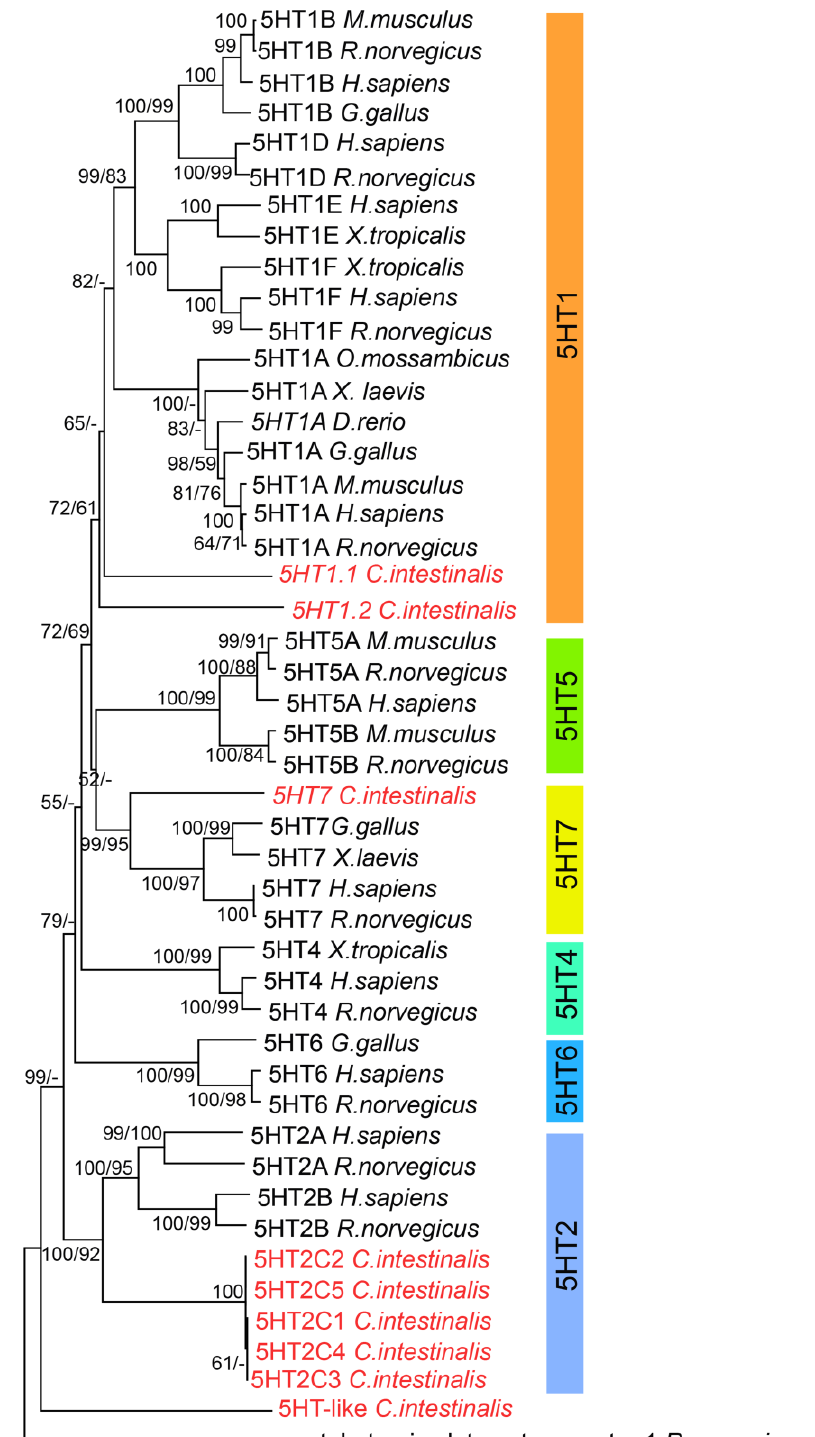
Figure 1. Phylogenetic tree of metabotropic serotonin receptors in vertebrates and Ciona . The evolutionary history was inferred using both the maximum likelihood (ML) and neighbor-joining (NJ) methods. The NJ tree is shown with bootstrap values for both NJ and ML analyses (first and second values, respectively). The percentage of replicate trees in which the associated taxa clustered together in the bootstrap test (500 replicates) is shown next to the branches. Bootstrap identical values in both NJ and MK are shown only once and values under 50% were collapsed. Differences in the two analyses are reported in the ML with an absent value. The tree was rooted using rat metabotropic glutamate receptor sequences as an outgroup.